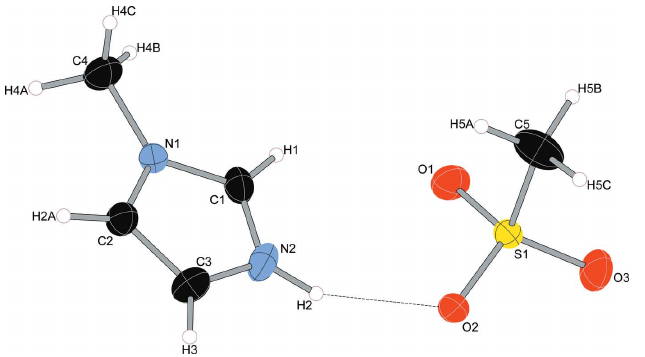
Figure 2 The asymmetric unit with displacement ellipsoids shown at the 35%